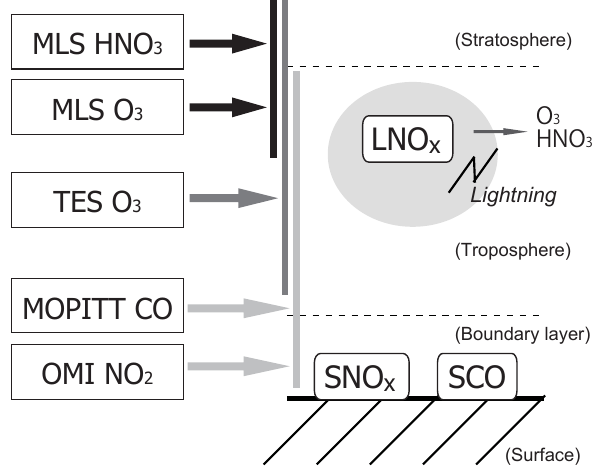
Fig. 1. Schematic diagram of the constraints on LNO x brought by the different satellite retrieval products. The vertical bars indicate the vertical sensitivity range for the species observed. Through these different sensitivities the assimilation system extracts information about the total LNO x source and its profile, the surface emissions, inflows from the stratosphere, and the chemical interactions in the troposphere through the observation of multiple species. Because these sensitivity ranges cover a large part of the troposphere, it is im- portant that the analysis simultaneously optimizes the LNO x source strength, surface emissions as well as concentrations of the reactive gases